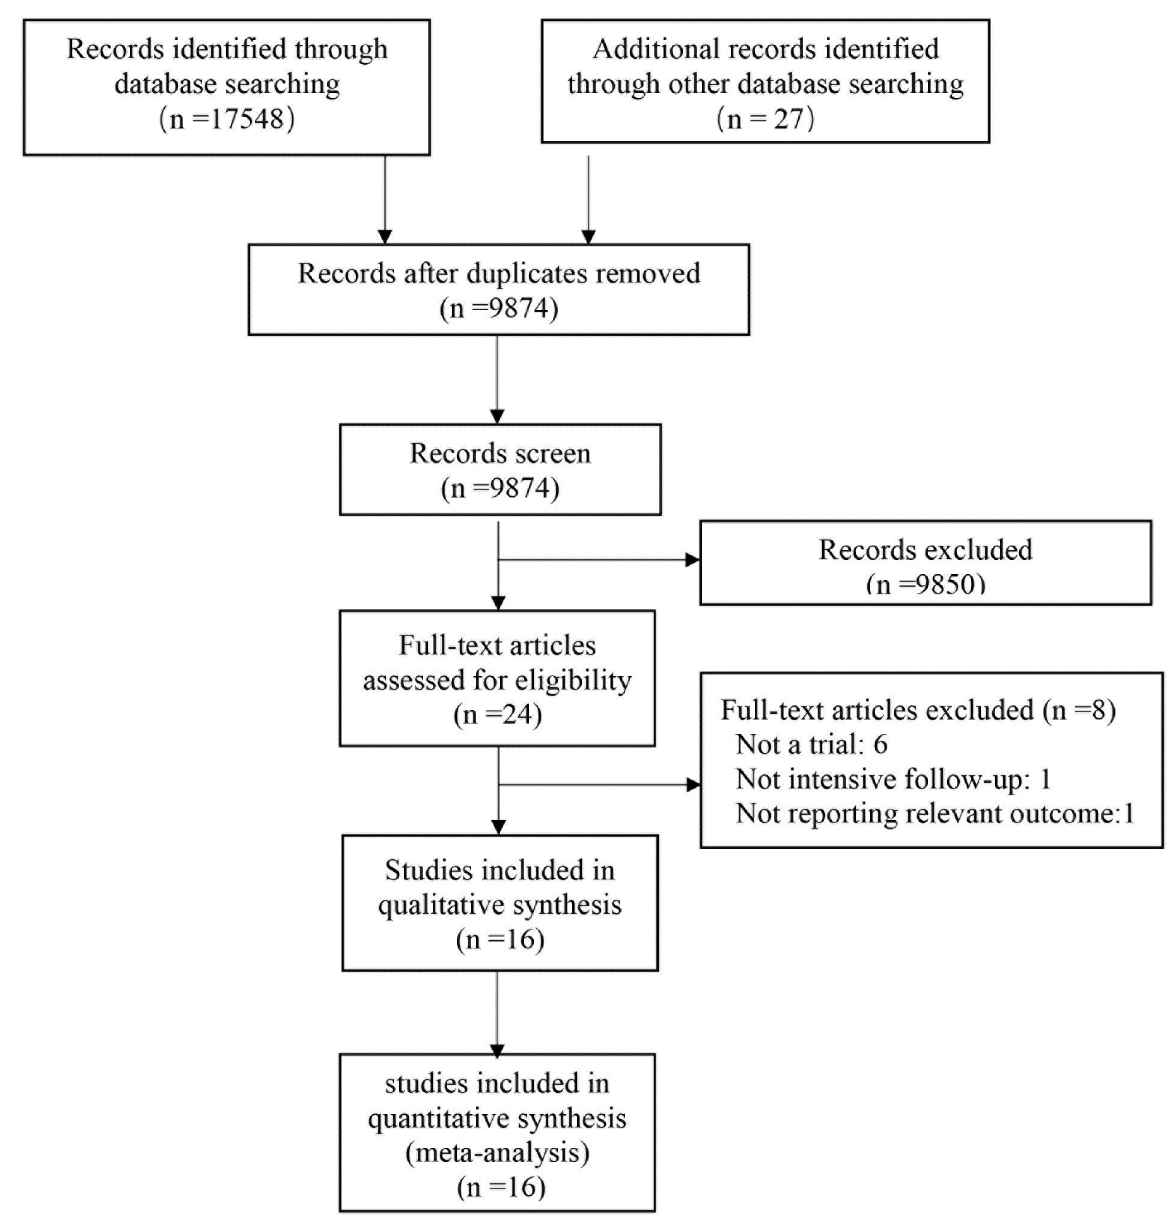
Fig 1. Flow diagram of the literature